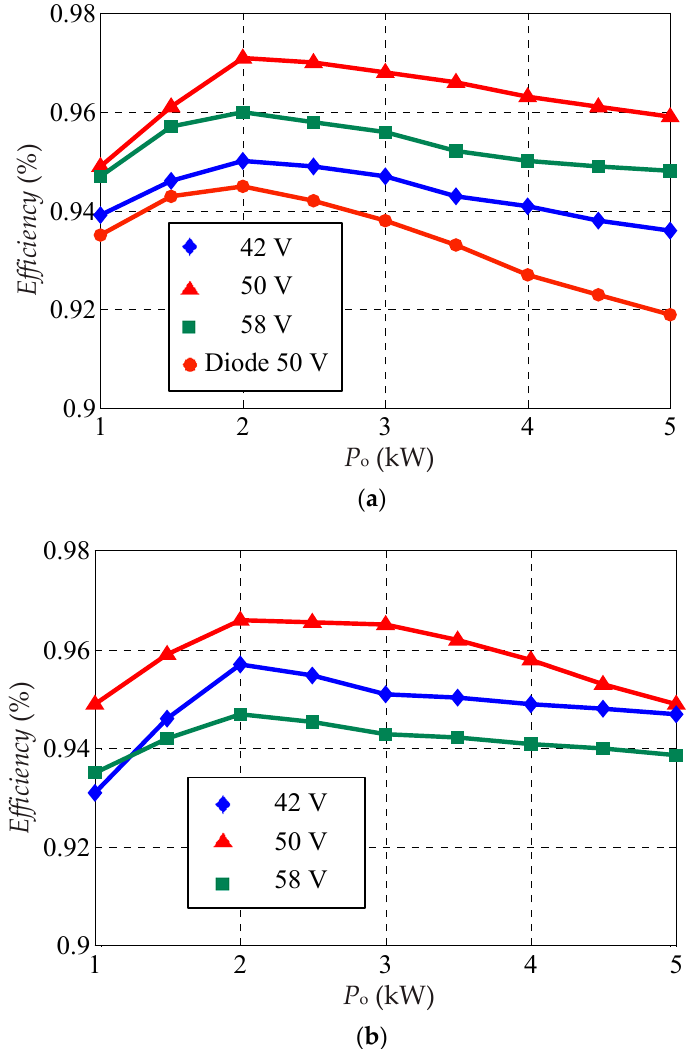
Figure 18. Measured efficiency: ( a ) forward mode; ( b ) backward mode.